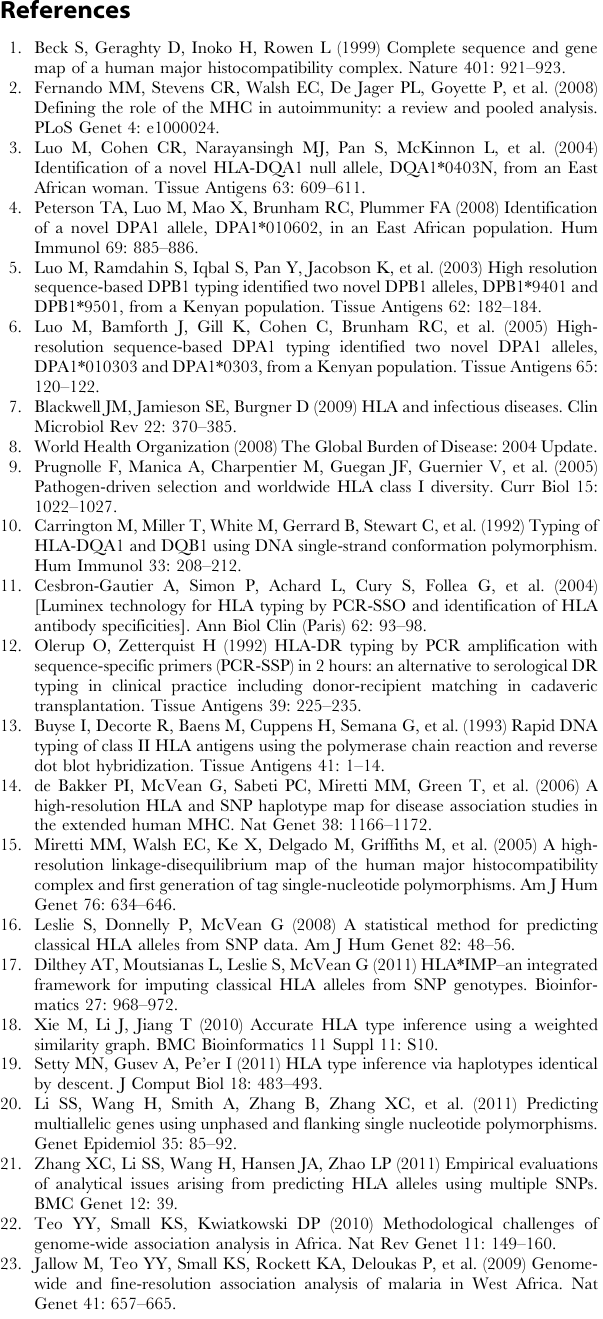
Table S3 Ten-Fold Cross Validation of Prediction of HLA-DRB1 and DQB1 Alleles. Table S4 Comparison of Selected Prediction SNPs in our Data with Published